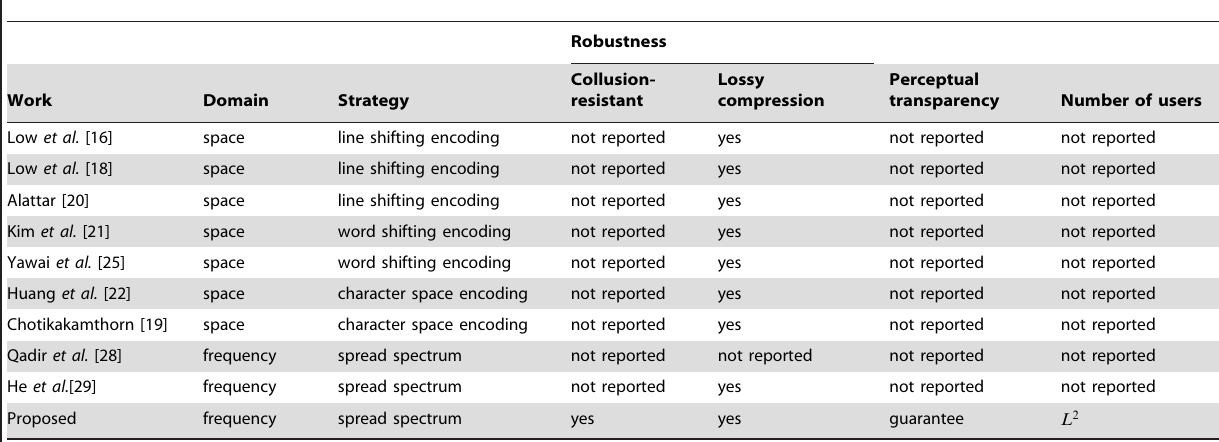
Table 5. Comparison between the proposed work and other insertion techniques of fingerprinting.